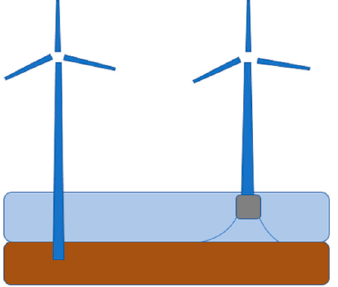
Figure 1. Main differences between bottom-fixed and floating wind turbines, simplified. Bottom-fixed (left side) and floating (right side) wind turbines. Whereas the bottom-fixed turbine is moored into the seabed (here illustrated by the example of a monopile), floating installations are anchored to it using different types of anchoring, here illustrated by the example of a spar buoy concept with catenary anchors.